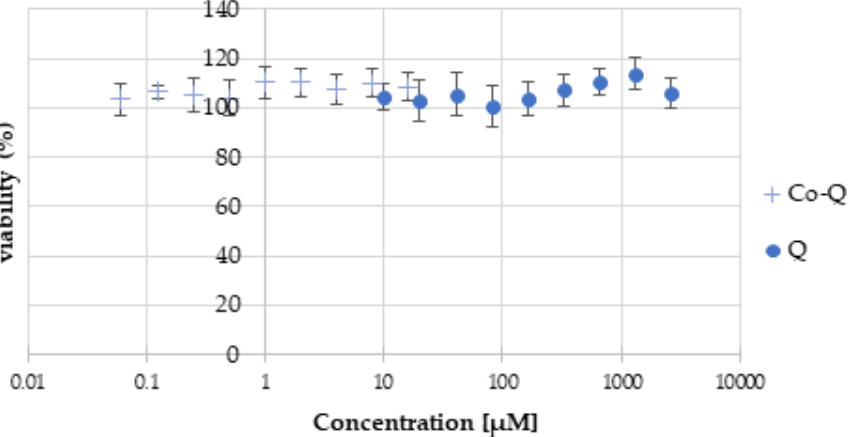
Figure 9. Toxicity of quercetin (Q) and its cobalt(II) complex of quercetin (Co-Q) against HaCaT immortalized human keratinocyte cell line, as measured by the fluorimetric neutral red uptake assay. The maximal concentration of Co-Q in the culture media was applied (15 µM). The concentration range for Co-Q was 0.06 – 15 µM, for Q it was 10 – 2 577 µM.